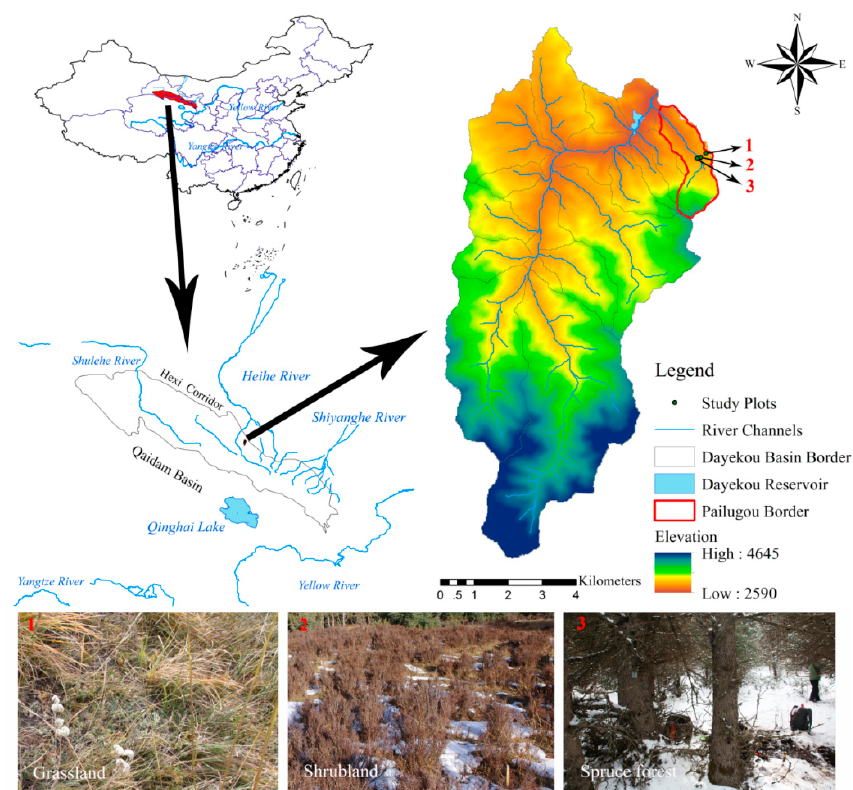
Figure 1. Map of the study area and the three typical vegetation types.